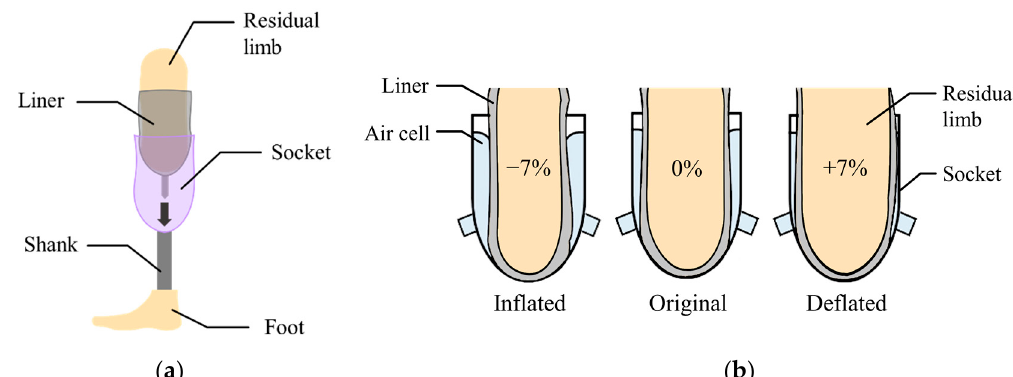
Figure 1. ( a ) The components of a lower limb prosthesis; ( b ) the volume compensation by inflation or deflation of the air bladder.